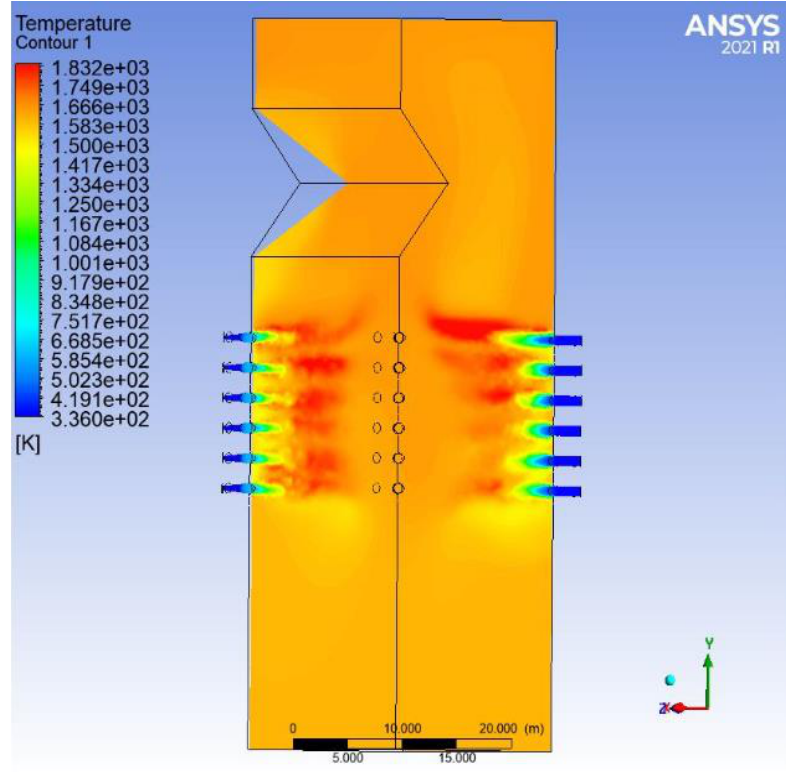
Figure 14. Temperature distribution of flue gas in case-VII.